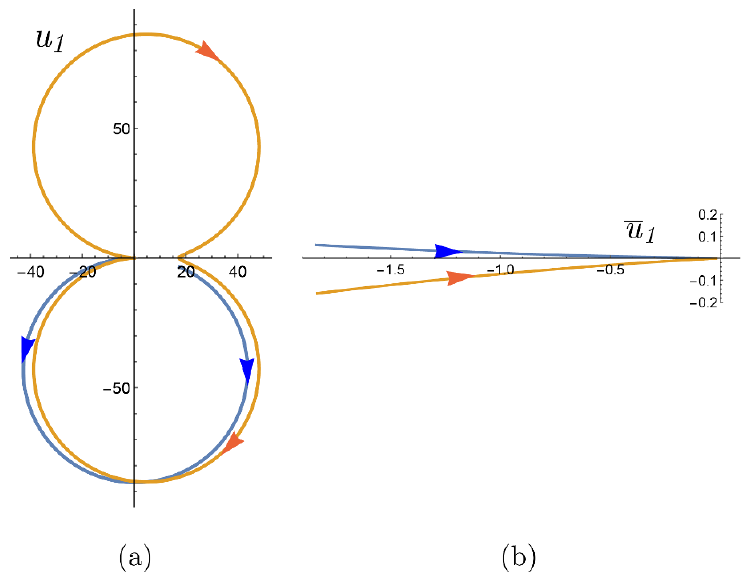
Figure 11 . Plots of u 1 (plot (a)) and (cid:22) u 1 (plot (b)) as a function of t . Blue and yellow are for V + and V (cid:0) respectively. One can see that u 1 stays on (cid:12)rst sheet for V + ( u 1 ), but moves to second sheet for V (cid:0) ( u 1 ); (cid:22) u 1 stays on (cid:12)rst sheet for both V (cid:6) ((cid:22) u 1